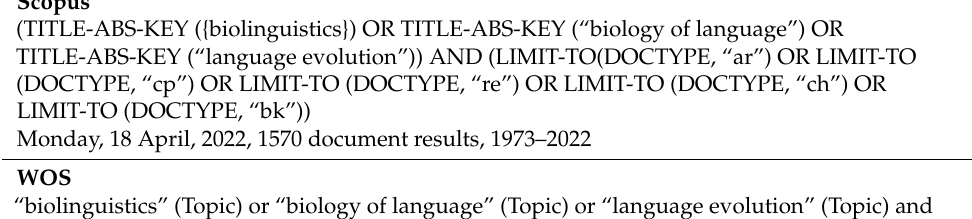
Table 2. Used search strings for biolinguistics in Scopus, WOS and Lens.